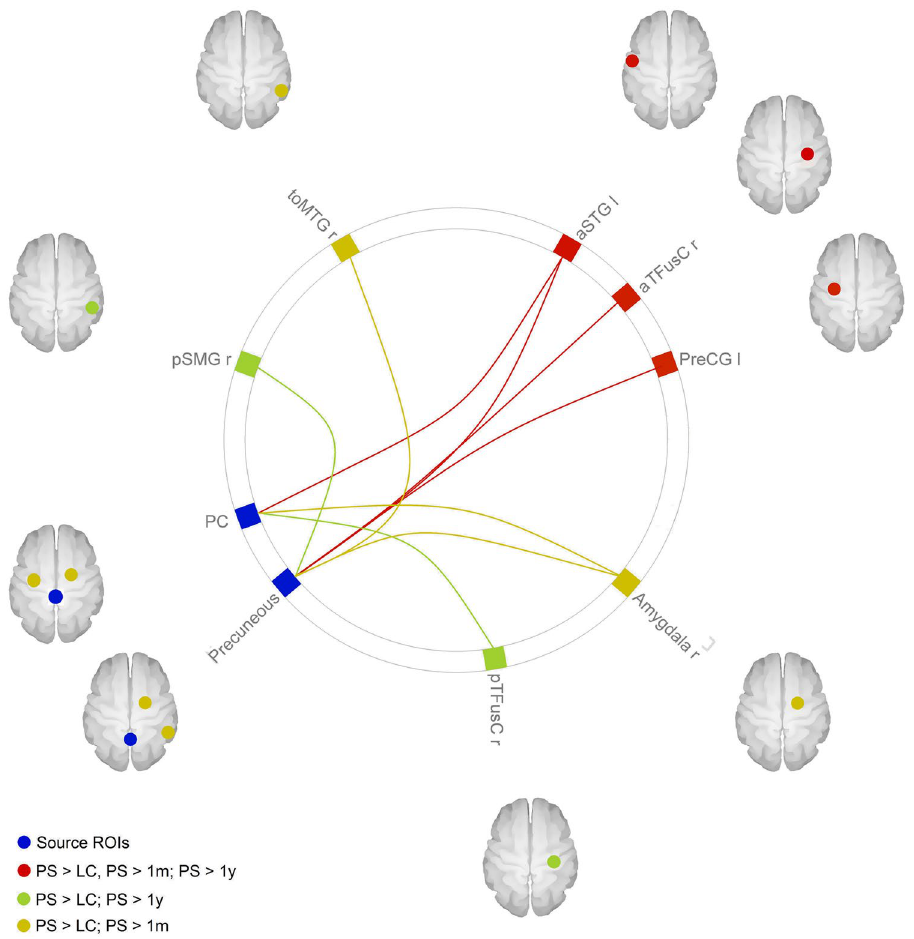
Figure 1. Seed-to-target connectivity changes over time. The figure shows the seed-to-ROI connectivity found to be significantly different between groups. The red lines represent connections found to be stronger in presurgery patients (PS) compared to all other groups (lean controls, 1 month follow-up and 1 year follow-up). The yellow lines represent connections where a minor change occurred, as they were found to be stronger in presurgery patients compared with both lean controls (LS) and 1 month follow-up (1 m), but not to 1 year follow-up (1 y) nor between lean controls and 1 year follow-up. The green lines represent the connections where a change in connectivity was observed more slowly, as their connectivity was stronger in presurgery patients compared with lean controls and 1 year follow-up, but not compared with 1 month follow-up. All results were significant with a p < 0.05, corrected for multiple comparisons with a FDR approach. The image was generated with the CONN software used for the